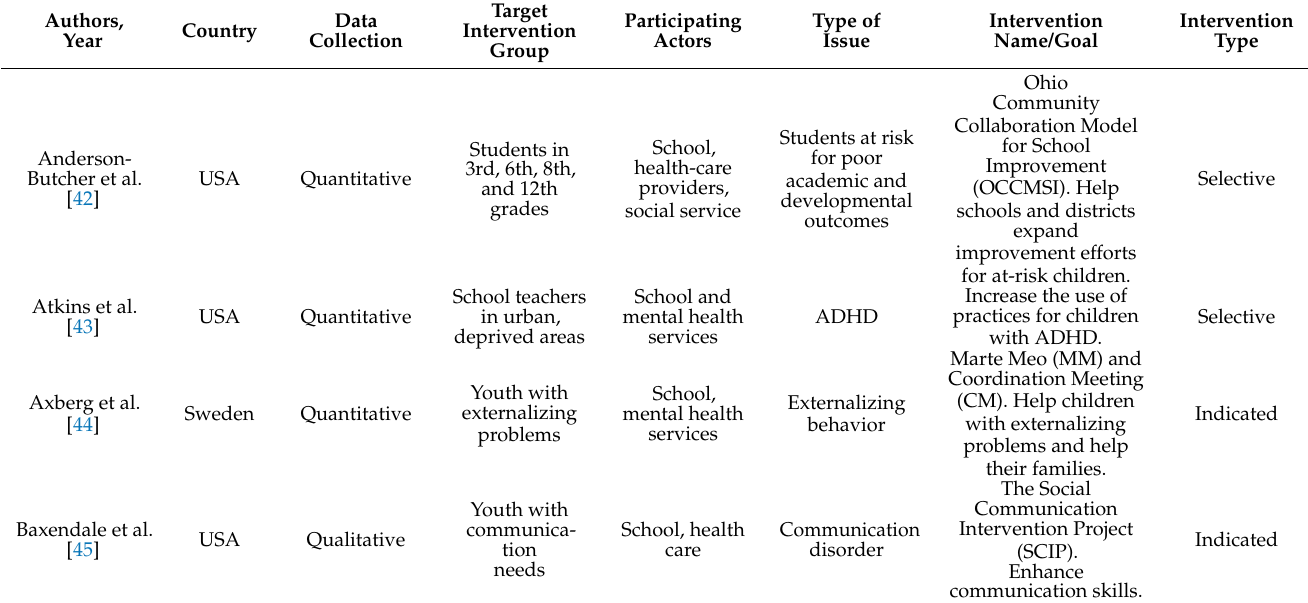
Table 1. Information about the studies.